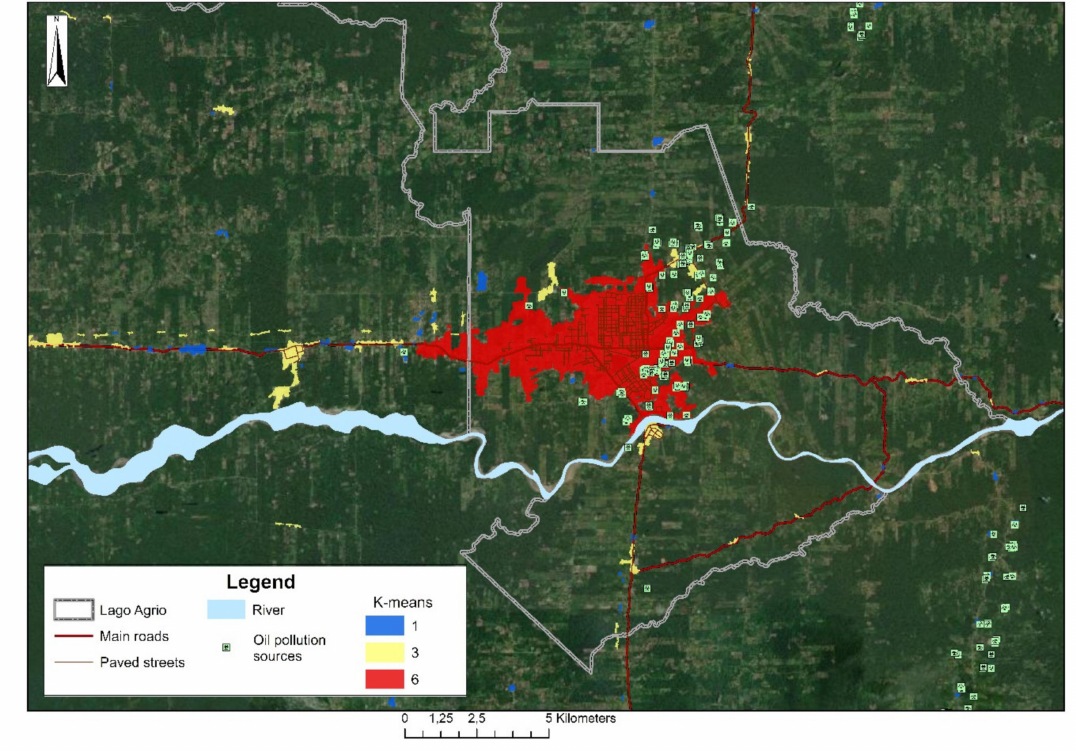
Figure 4. The urban region 6: The city of Lago